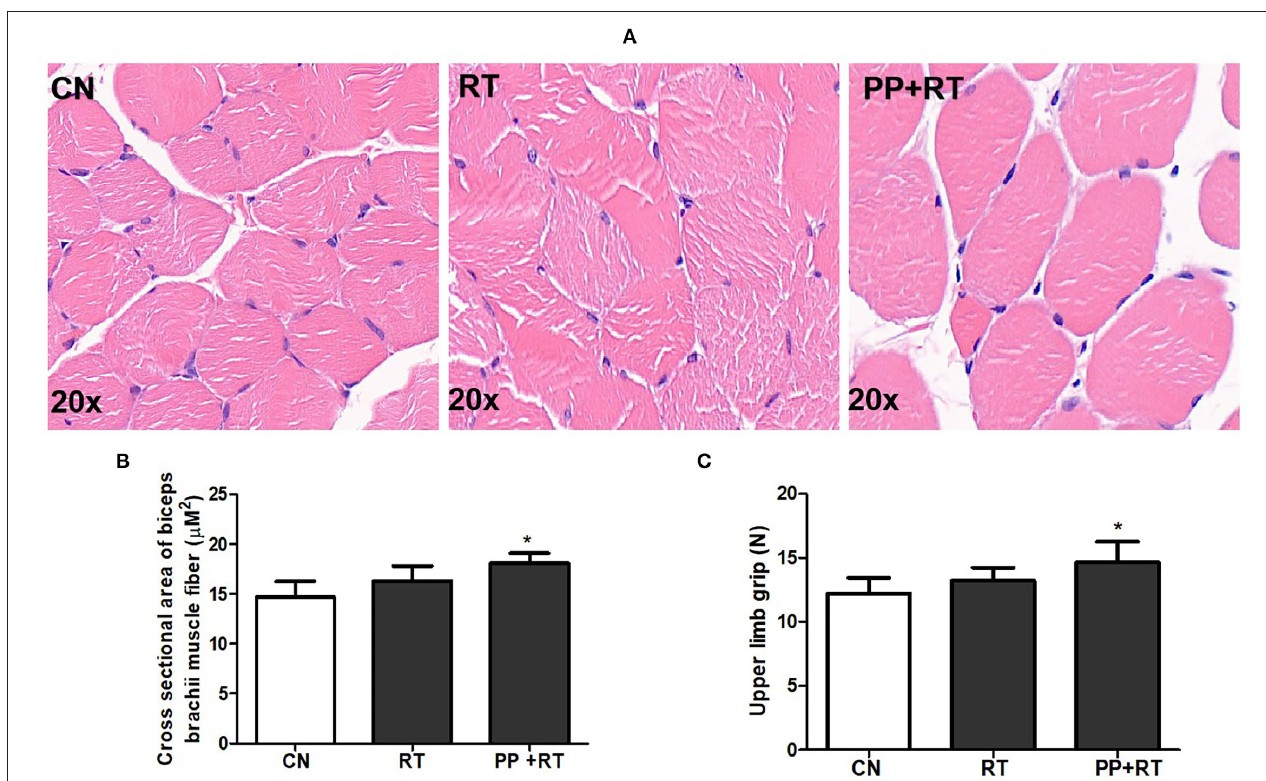
FIGURE 2 | Pea peptide supplementation combined with resistance exercise increased cross-section of muscle fiber and forelimb grip in rats. (A) HE staining of biceps brachii in the rats of CN, RT, and PP + RT group (20 x); (B) Statistical analysis of (A) ; (C) Upper limb grip of rats in CN, RT and PP + RT group; CN, Control group; RT, Resistance training group; PP + RT: Pea peptide supplementation combined with resistance training. The significant difference between groups was validated with one-way ANOVA using GraphPad Prism 6, * p < 0.05 vs. CN group (n = 5/group). Data are presented as mean ± standard deviation (M ± SD).